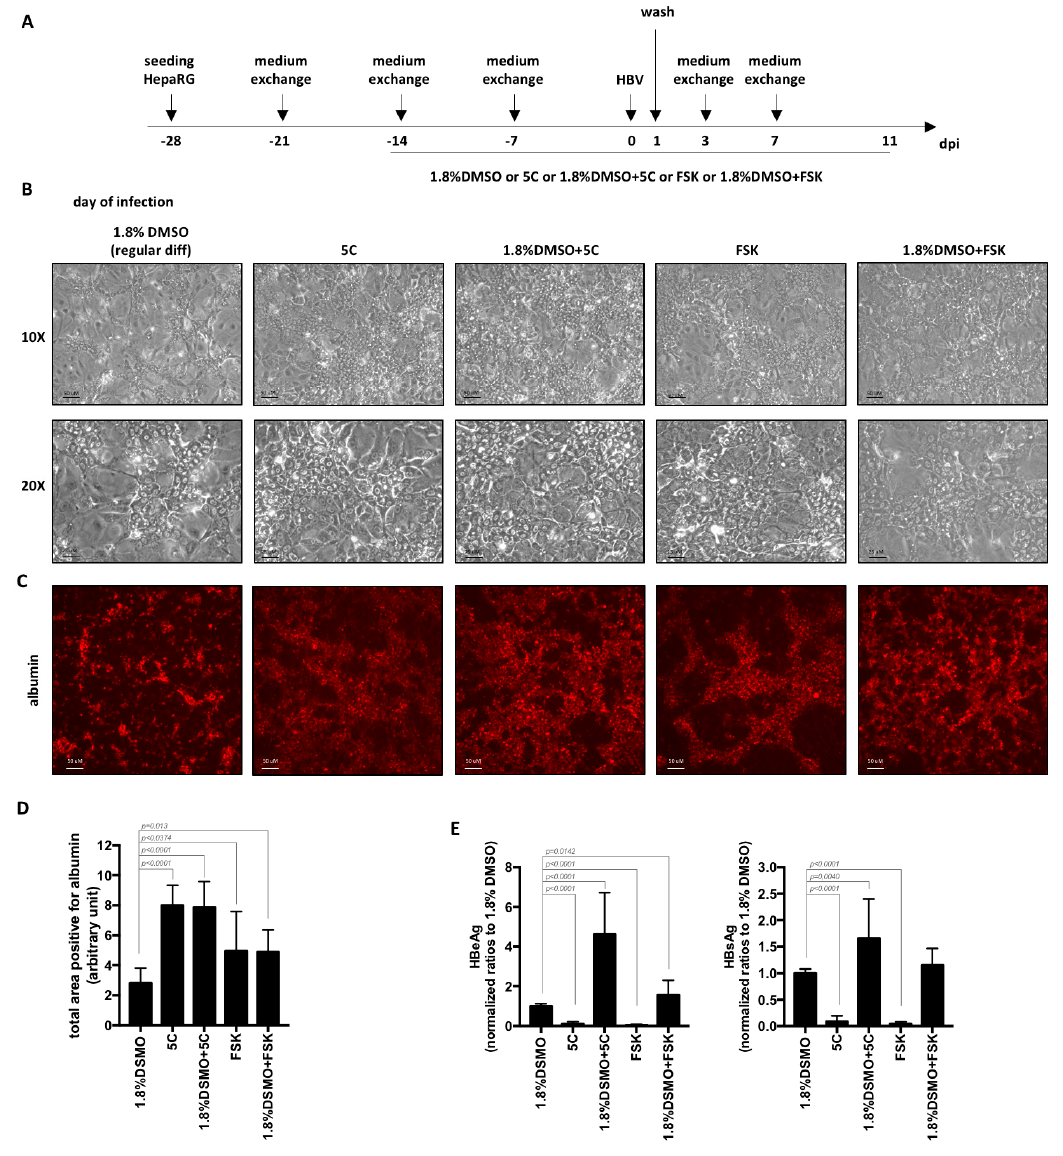
Figure 2. Differentiation of HepaRG with 5C or FSK complemented to 1.8% DMSO increase the levels of secreted HBV antigens. ( A ) HepaRG cells were seeded, treated and HBV-infected (500 vge / cells) as indicated. ( B – D ) At the end of the 4 weeks’ differentiation, cells were ( B ) observed by phase contrast microscopy or ( C , D ) stained with anti-albumin antibodies. ( D ) Total positive area for albumin were measured using ImageJ. Bars represent the mean +/ − SD of 12 fields from two different batches of HepaRG cells. ( E ) Supernatants were collected 7 days post-infections and levels of HBeAg and HBsAg analyzed by ELISA. Bars are the means +/-SD of three independent experiments each performed with three biological replicates. p values were calculated using the Prism software and Mann–Whitney analyses.